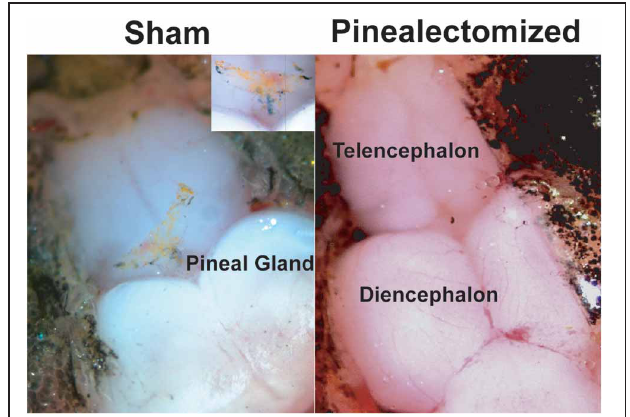
FIGURE 1 | Representative pictures of zebrafish brain. Left: Sham operated animal depicting an intact pineal gland (see also inset). Right: Photograph of pinealectomized zebrafish brain. Note the absence of a pineal gland between the telencephalon and the diencephalon in the photograph to the right as compared to the left.